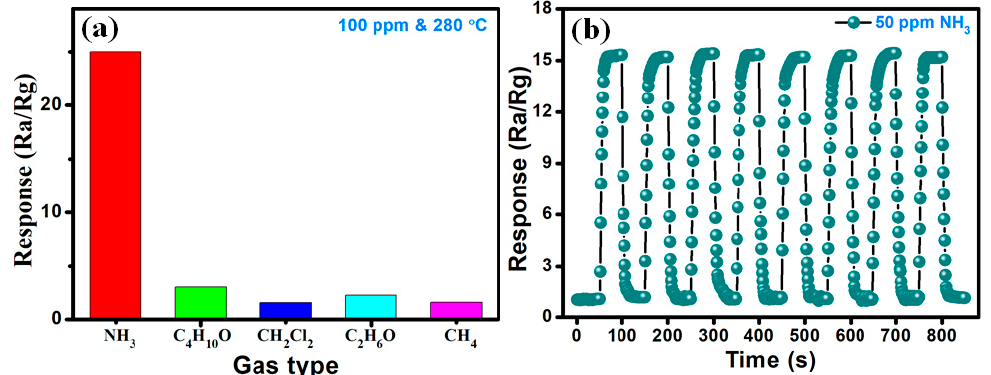
Figure 10. ( a ) Selectivity of Zn 1 Ni 2 gas sensor toward various gases (100 ppm) at 280 °C . ( b ) Reversibility of Zn 1 Ni 2 for 50 ppm NH 3 .